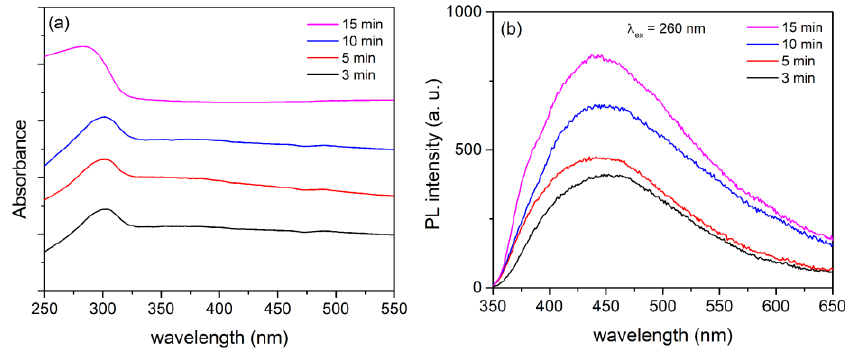
Figure 8. ( a ) DRS spectra; ( b ) PL emission spectra; Ta 2 O 5 coatings formed at various stages of the MDs. the